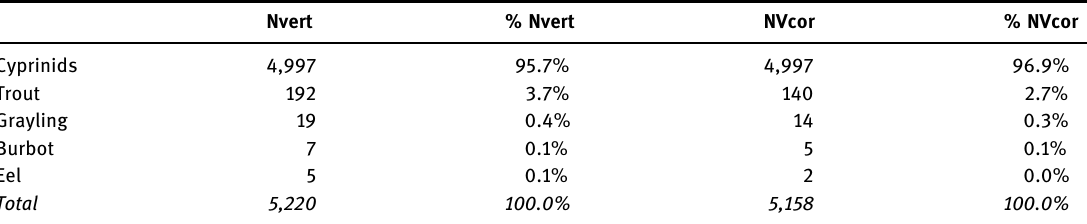
Table 5: Relative abundance of fi sh taxa represented in the Ranchot Layer 3 assemblage: Nvert = number of vertebrae, NVcor = corrected number of